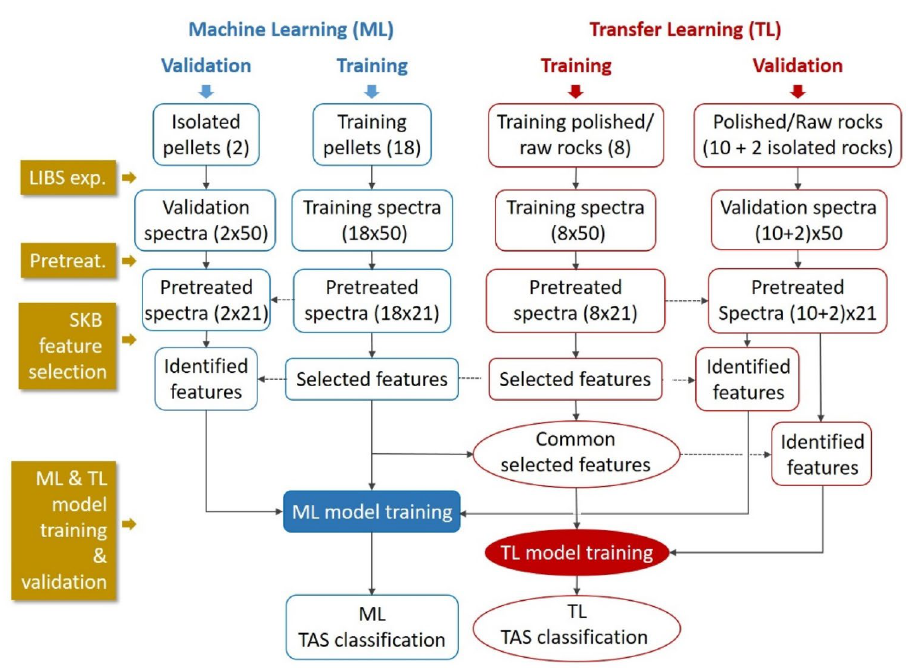
Figure 3. General flowchart used in this work allowing a comparative study between the performances of a machine learning (ML) model and those of a transfer learning (TL)